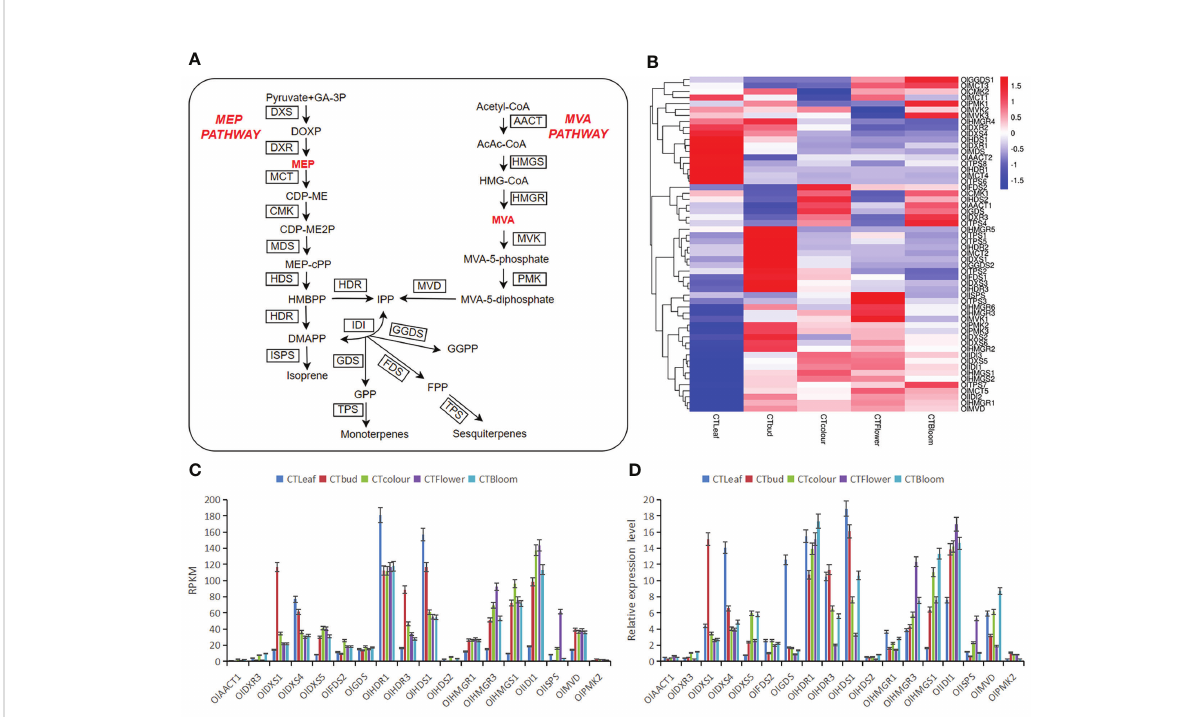
FIGURE 5 Important factors mediating the terpene biosynthesis pathway in O. longilobus and the expression patterns of 18 selected genes determined by the qRT-PCR analysis. (A) Important factors in the O. longilobus terpene biosynthesis pathway. GA-3P, glyceraldehyde-3-phosphate; DOXP, 1-deoxy-D- xylulose 5-phosphate; DXS, DOXP synthase; DXR, DOXP reductoisomerase; MEP, 2-C-methyl-D-erythritol 4-phosphate; MCT, 2-C-methyl-D- erythritol 4-phosphate cytidylyltransferase; CDP-ME, 4-(cytidine 5 ′ -diphospho)-2-C-methyl-D-erythritol; OlK, CDP-ME kinase; CDP-ME2P,